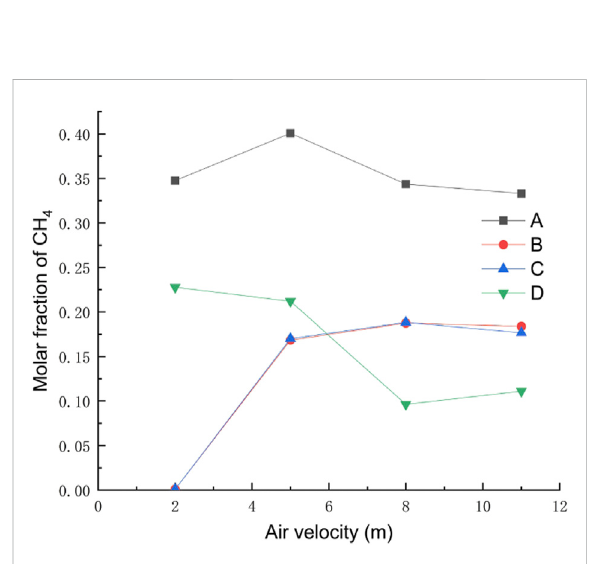
FIGURE 13 Diffusion height diagram of ambient wind speed at different